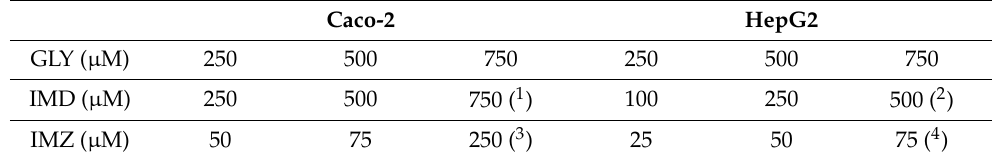
Table 2. Concentrations of glyphosate (GLY), imidacloprid (IMD) and imazalil (IMZ) chosen